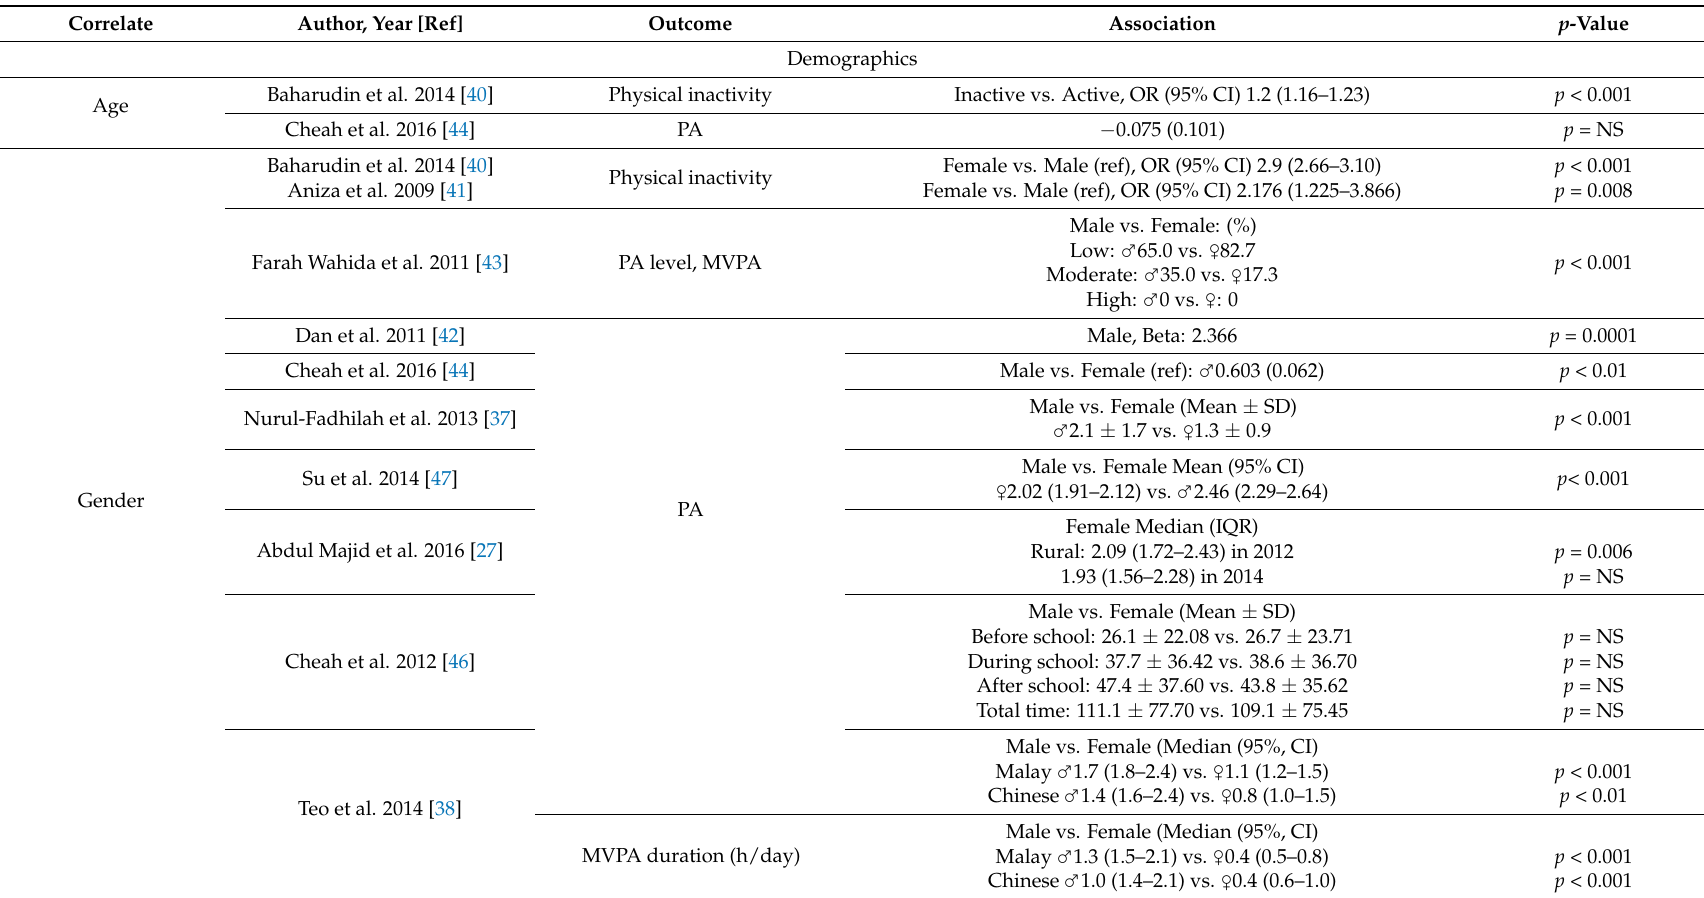
Table 3. Summary of associations between physical activity determinants and physical activity